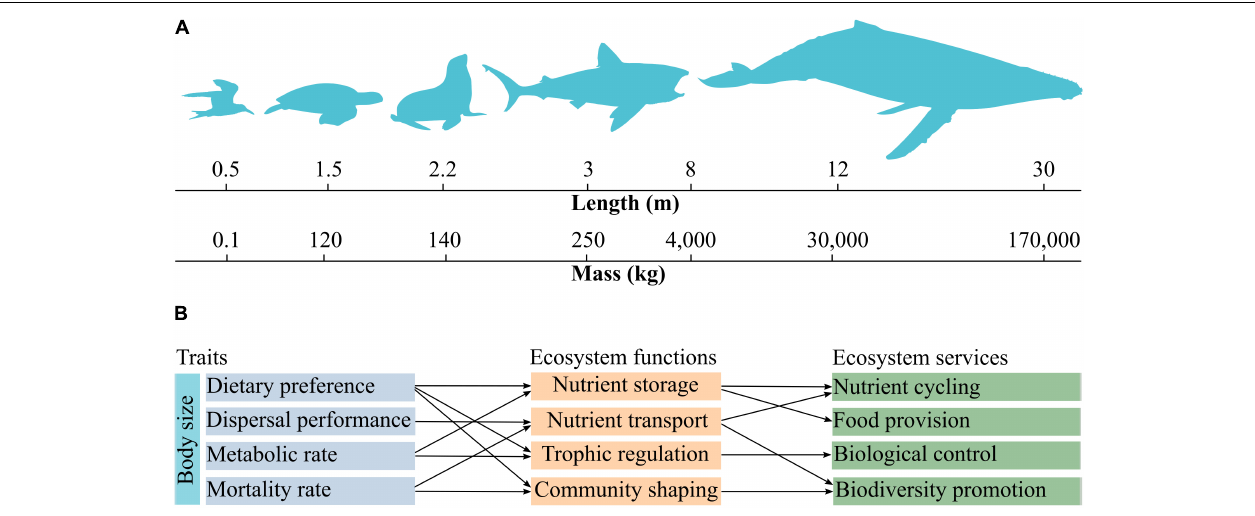
FIGURE 1 | Key traits shared by marine megafauna and their relationships with ecosystem functions and services. Body length and body mass are correlated with each other and vary over several groups (A) . Body size can be considered as a master trait as it influences other physiological, behavioral, and demographic characteristics such as dietary preference, dispersal performance, metabolic rate, and mortality rate. These traits are associated to specific ecosystem functions and services (B) . Trophic regulation refers to trophic-dynamic regulation of populations. Community shaping refers to shifts in community composition driven by ecosystem engineering and/or species interactions (e.g., predation). The nomenclature of ecosystem functions and services follows Costanza et al.